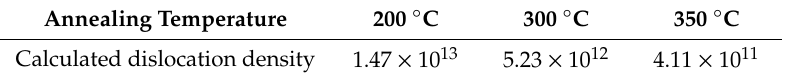
Figure 4. ( a – c ) Electron backscatter di ff raction (EBSD) orientation micrographs, ( d – f ) kernel average misorientation maps of Al–10Mg alloy annealed at ( a , d ) 200 ◦ C, ( b , e ) 300 ◦ C, ( c , f ) 350 ◦ C. Black line in ( a – c ) represents misorientation angle θ > 15 ◦ . Red regions in ( d – f ) represent high misorientation with neighboring points and blue regions represent low misorientation with neighboring points. Table 3. Dislocation density (m − 2 ) of Al–10Mg alloy annealed at di ff erent